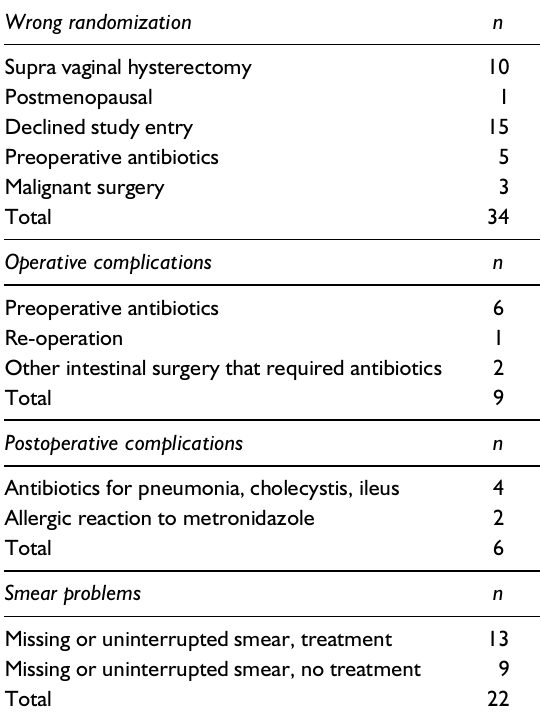
Table 1 Excluded patients ( n =